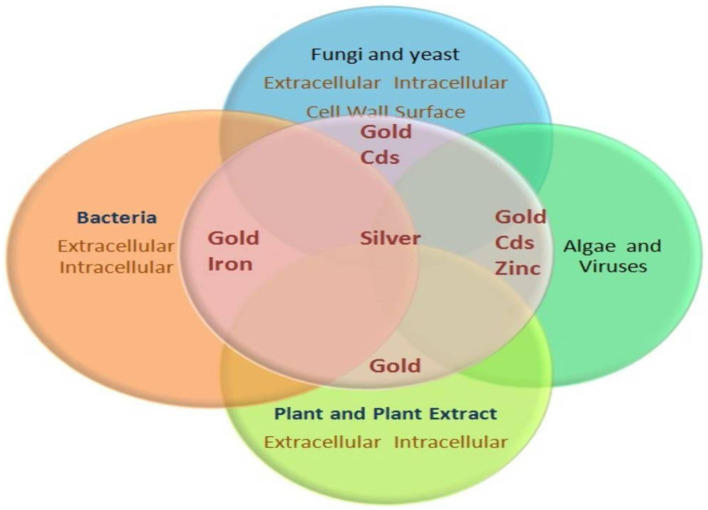
Various biological synthesis of nanoparticles.